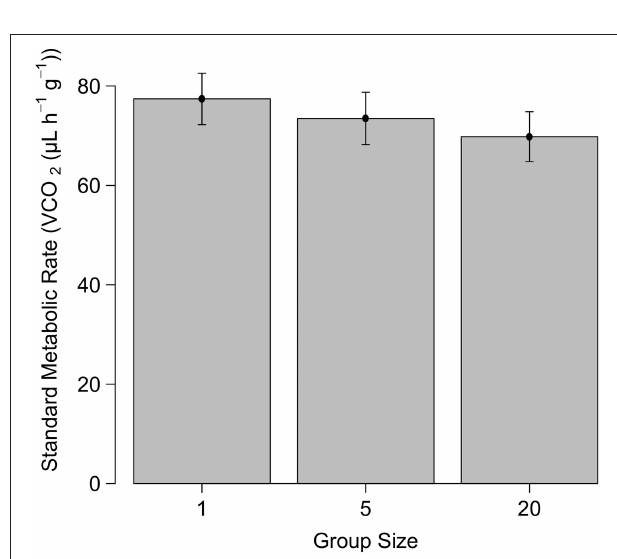
FIGURE 2 | The standard metabolic rate (mean ± SE) at 22 ◦ C of Stegodyphus dumicola spiders kept at different group sizes.